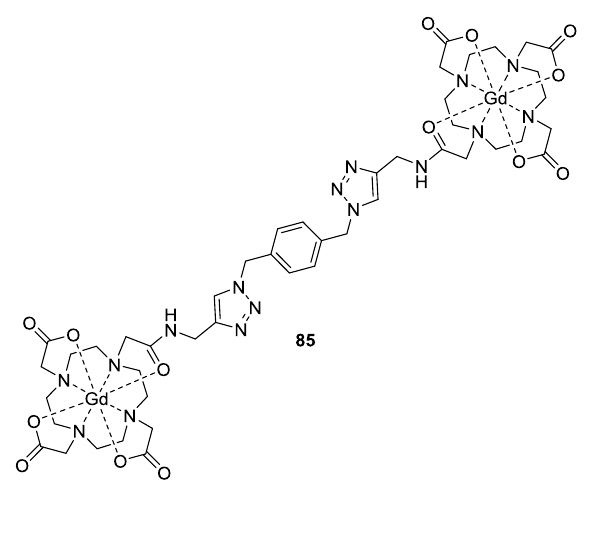
Figure 9. Structure of flexible Gd(III)-based model complex .